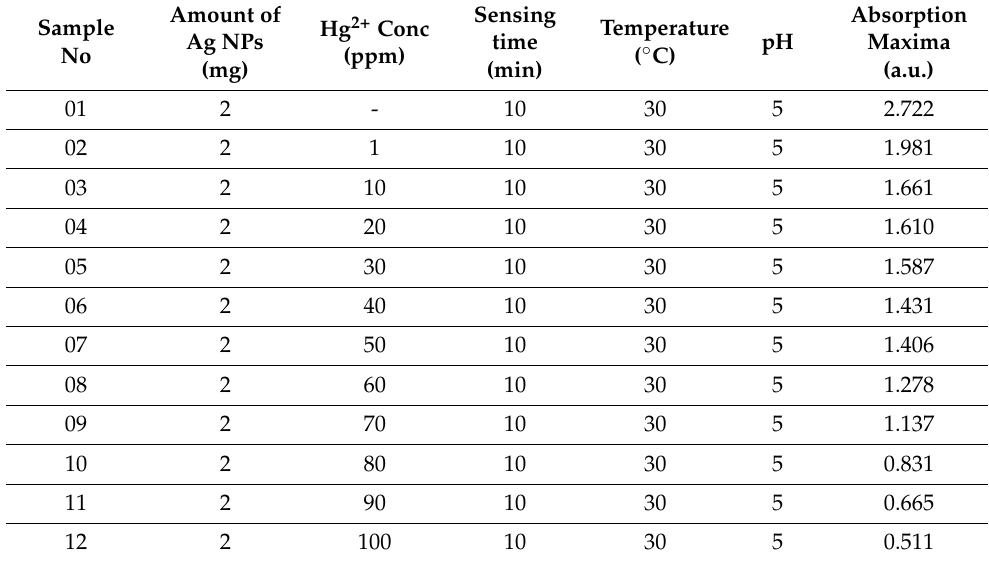
Table 4. Experimental details for sensing of different concentrations of Hg 2+ by Ag